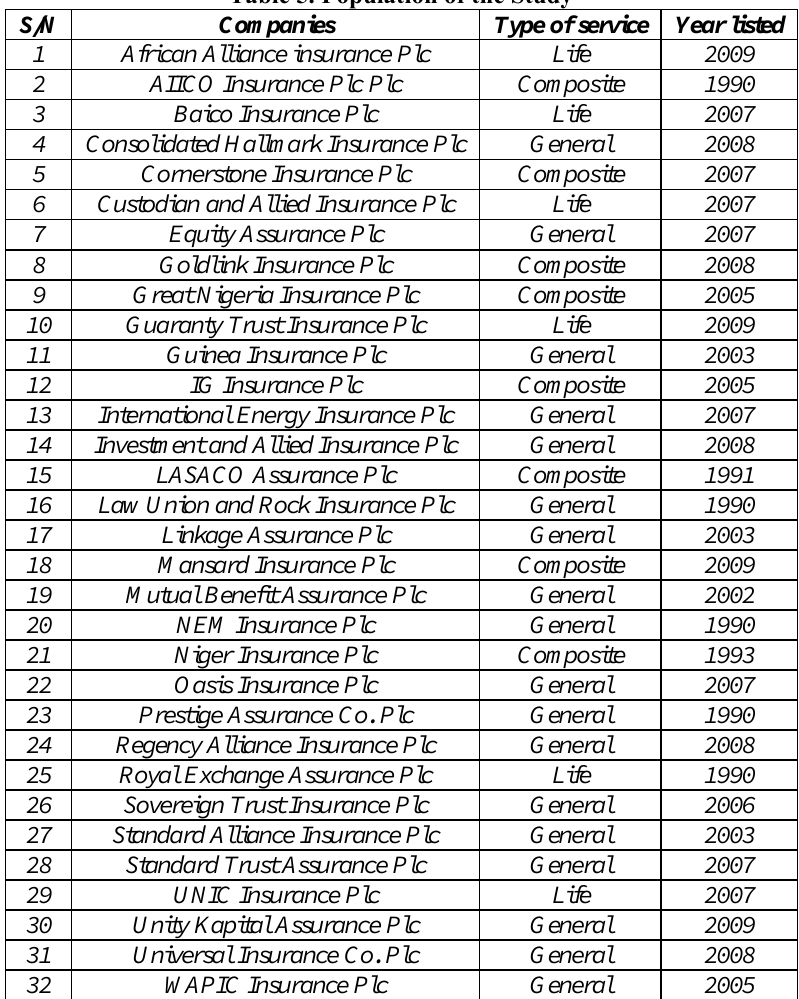
Table 5. Population of the